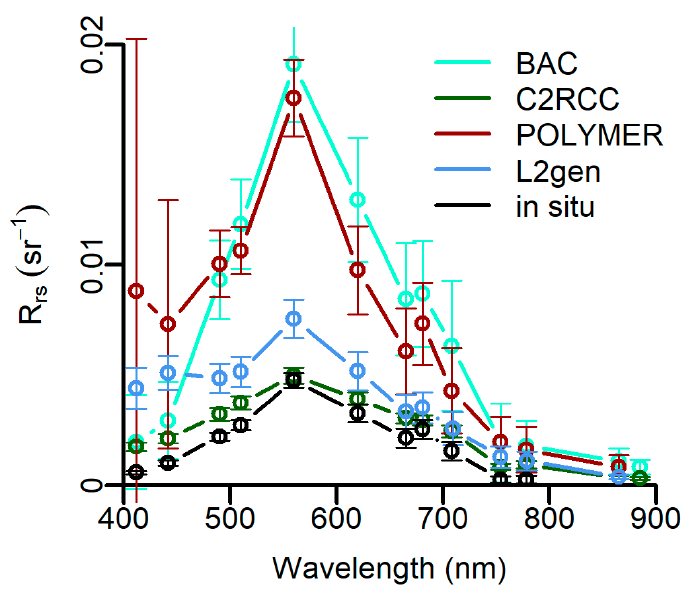
Figure 4. Median satellite-derived R rs processed by each atmospheric correction algorithm and in situ R rs spectra (black) across all matchups. Error bars represent standard error. Table 1. Statistical matchup results for satellite-derived R rs processed by each atmospheric correc- tion algorithm against in situ R rs .